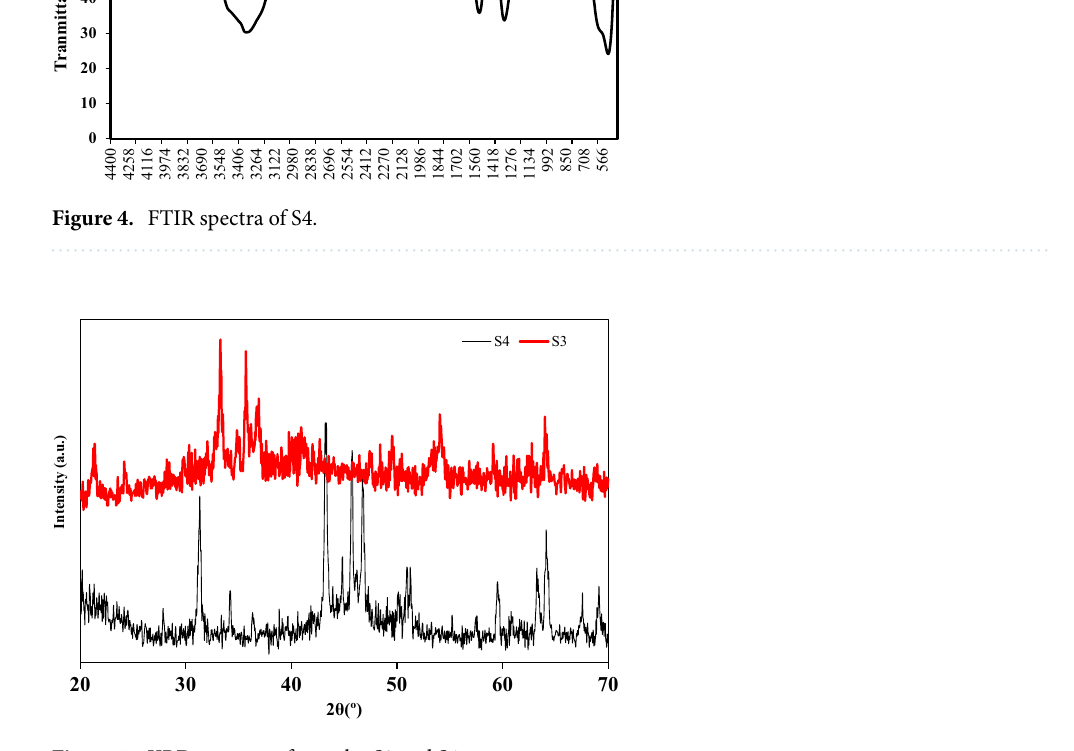
Figure 5. XRD patterns of samples S3 and